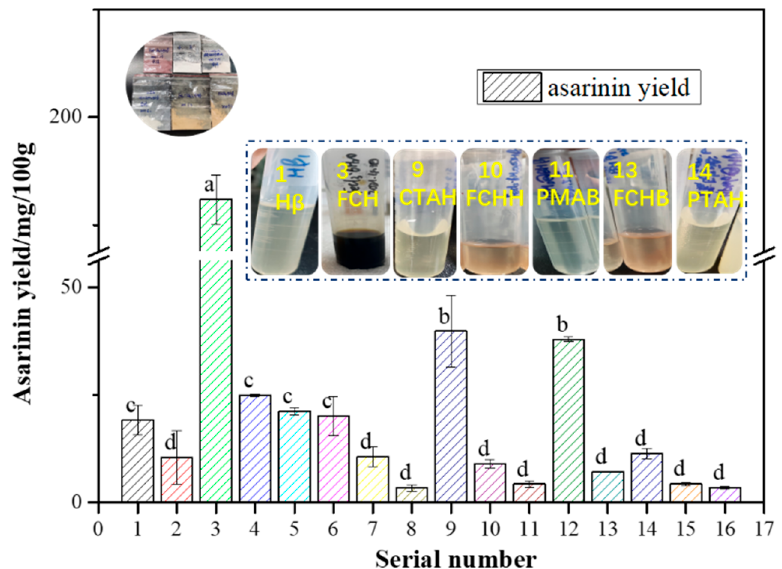
Figure 3. Effects of various catalysts on the yield of asarinin under the following reaction conditions: reaction temperature, 80 °C; reaction time, 2 h; catalyst amount, 1.0%. Different letters above the bars show significant differences among various treatments. The various solid acid catalysts represented by the serial number in the Figure are shown in Table 1.